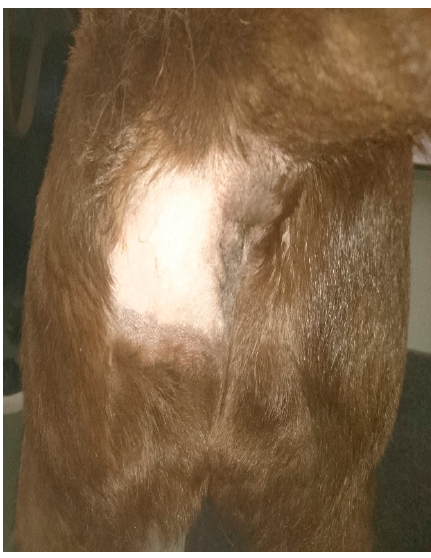
Figure 3. Six weeks post treatment.